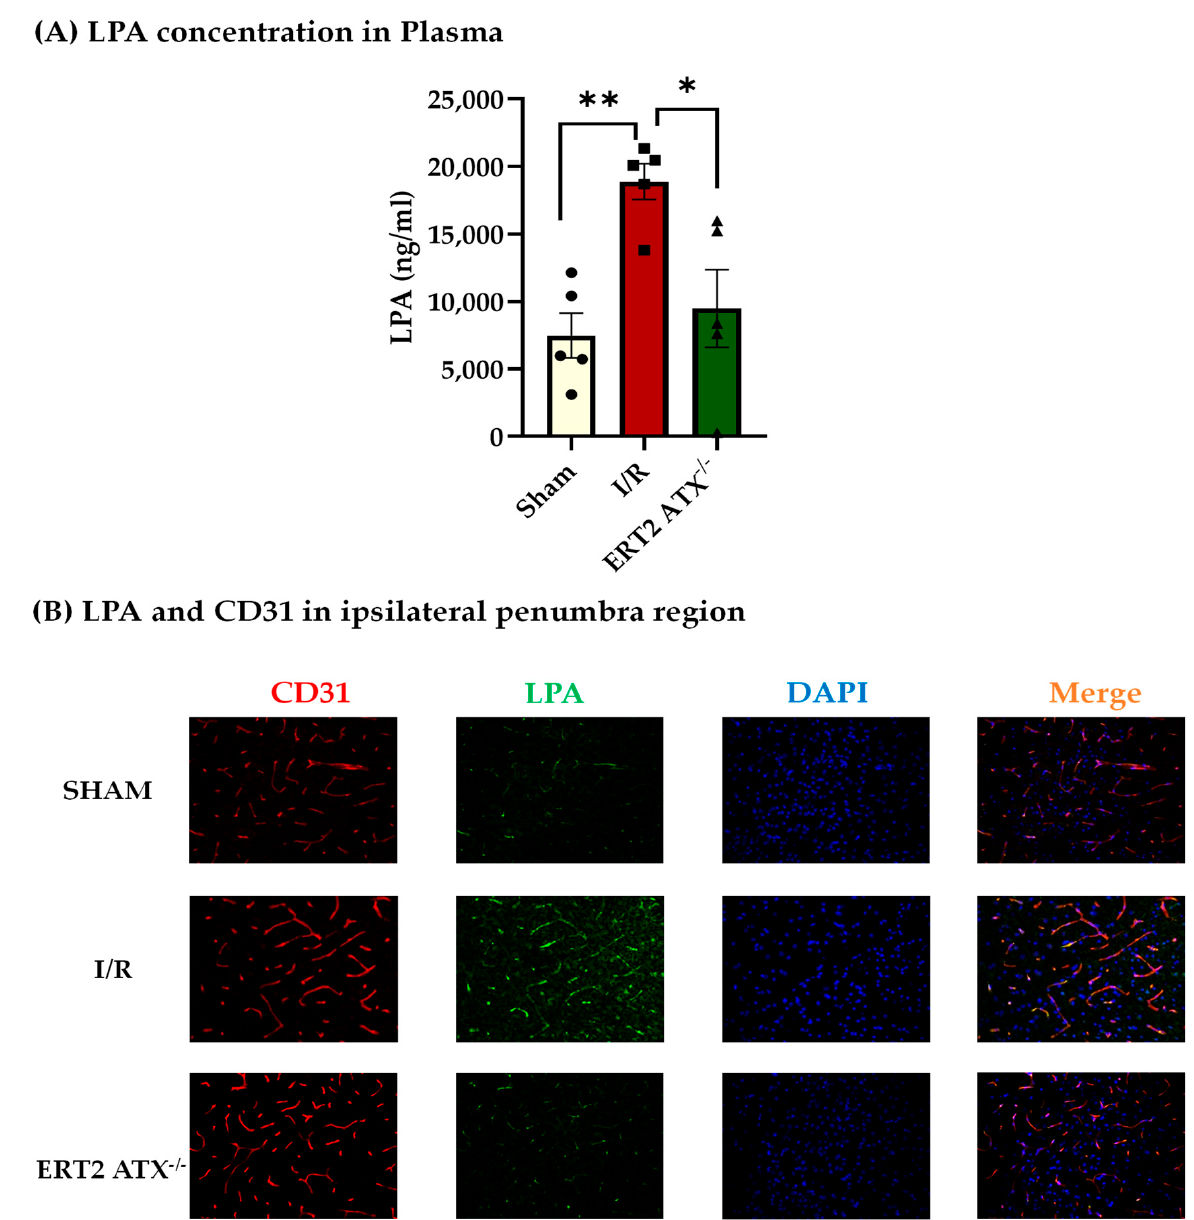
Figure 3. LPA decreased in ERT2 ATX − / − following I/R. ( A ) LPA concentration in mice plasma quantified using ELISA kit in sham, I/R and ERT2 ATX − / − mice, n = 5. ( B ) LPA (for lysophosphatidic acid) and CD31 (for endothelial cells/ blood vessels) immunostaining in mice brain cryosections, n = 5. LPA is labeled in green, CD31 (marker for endothelial cells) in red, and DAPI (marker for nuclei) in blue (20× magnification). All values are mean ± SEM. * p < 0.05 and ** p < 0.01 show significance compared to using ANOVA followed by the Bonferroni post hoc